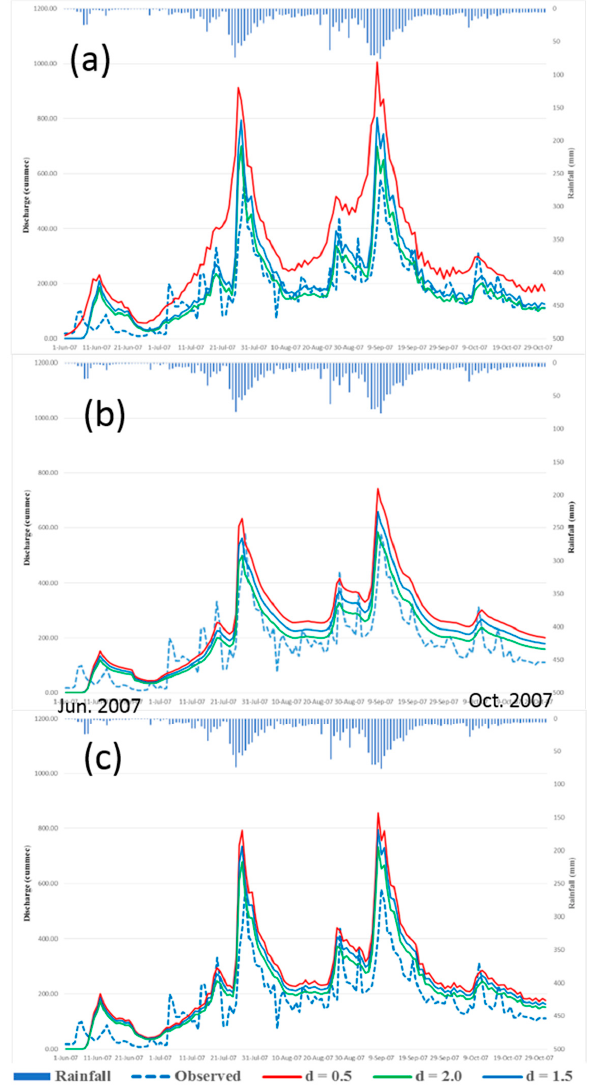
Figure 8. Sensitivity to soil depth values in ( a ) SRTM DEM, ( b ) ASTER DEM, and ( c ) CARTO DEM based on the discharge at the outlet.